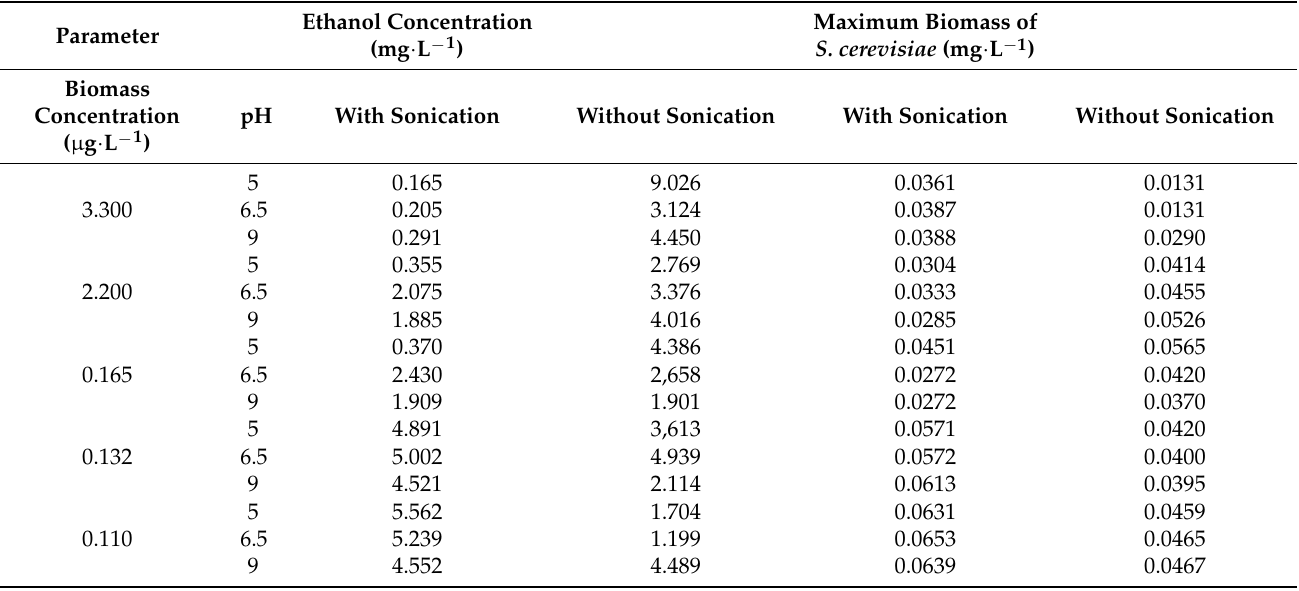
Table 2. Comparison of ethanol concentrations produced from various biomass concentrations (with and without sonication), pH values, and maximum biomass of S. cerevisiae